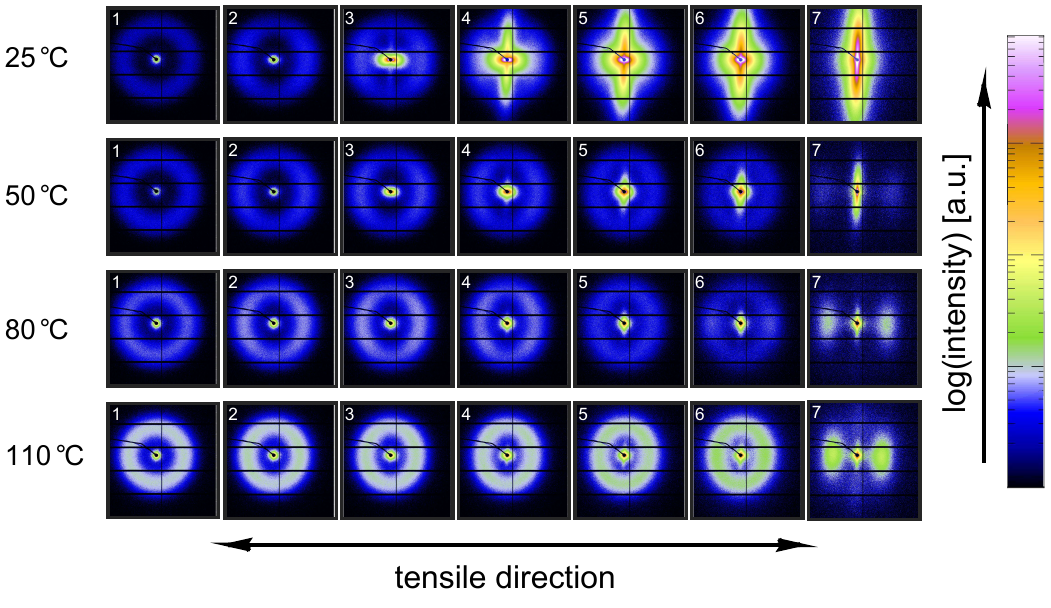
Figure 21. Normalized 2D SAXS patterns of α -iPP stretched at temperatures of 25, 50, 80 and 110 ◦ C from top to bottom. The true strains, determined with the assumption of fully uni-axial deformation, are given as well. The macroscopic strains at which the patterns were taken are indicated by the markers in Figure 8. The stretching direction is